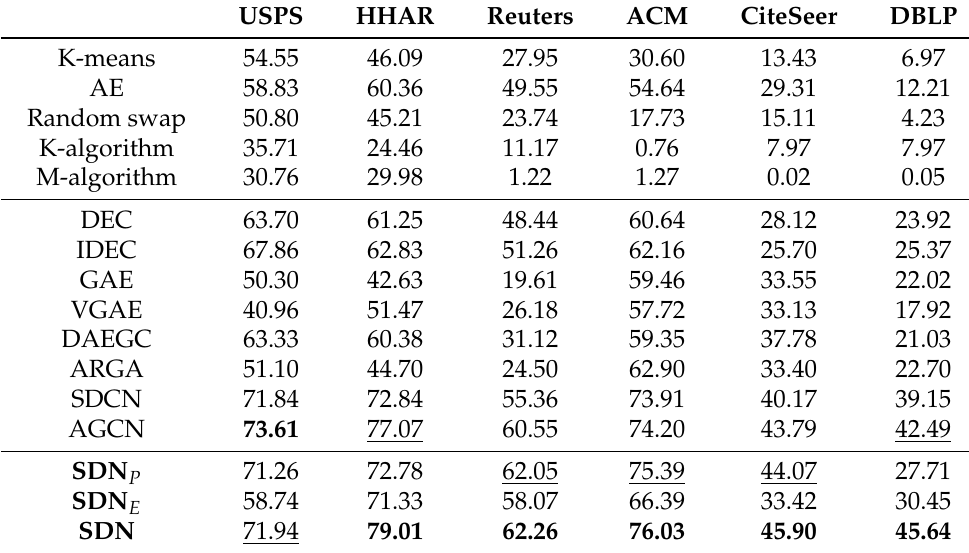
Table 7. Average Rand Index (ARI) results on six datasets.